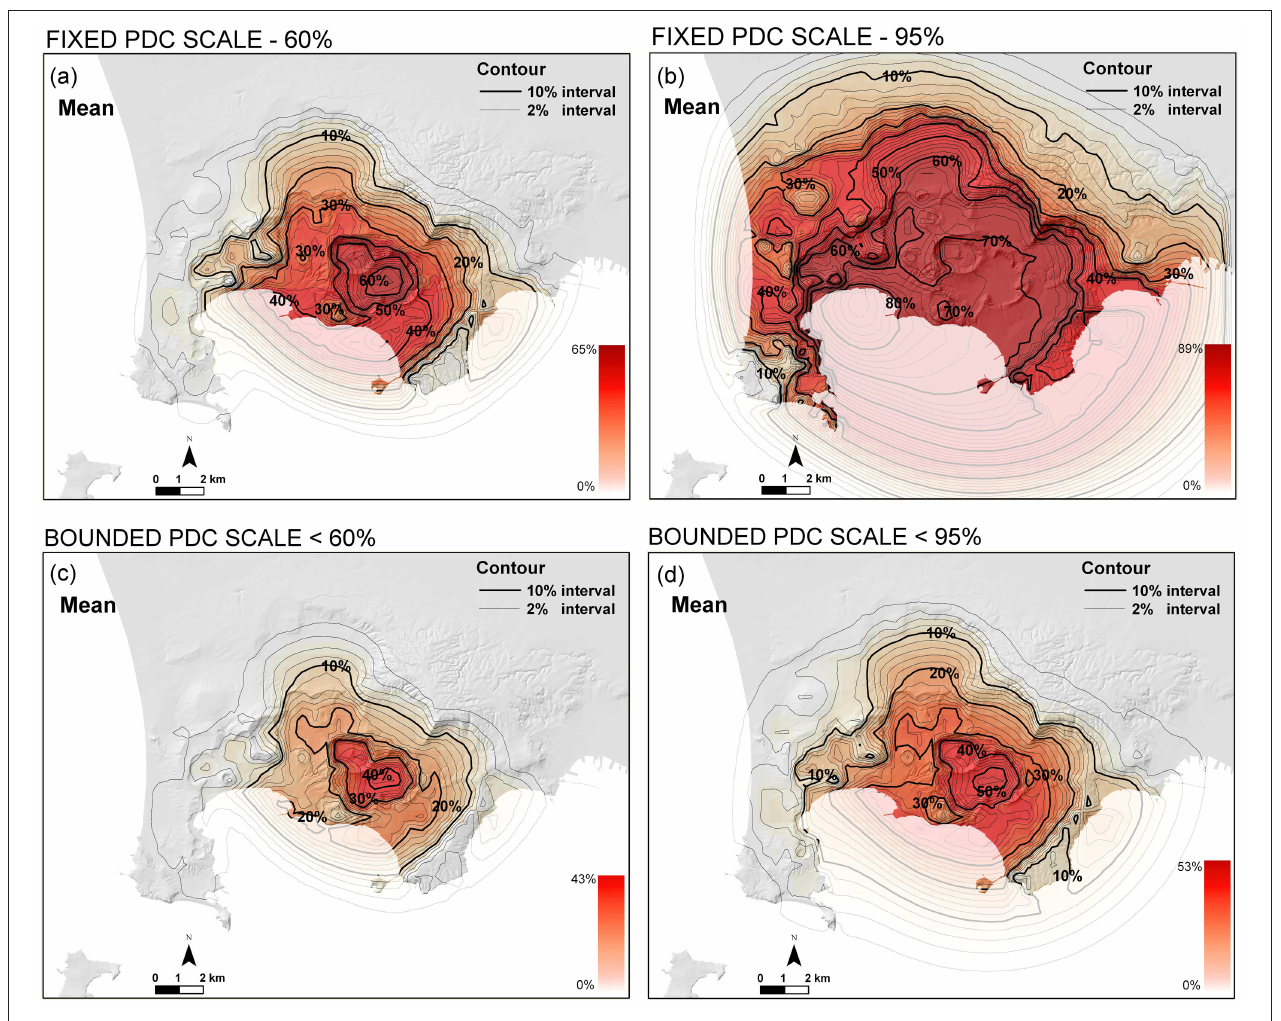
FIGURE 5 | (a,b) Mean PDC invasion hazard maps produced by assuming PDC invasion areas corresponding to the 60% (a) , and 95% (b) , respectively, of the distributions reported in Figure 3b . The two maps assume the vent opening probability displayed in Figures 3c,d for the two sectors of the caldera. Contours and colors indicate the mean percentage probability of PDC invasion conditional on the occurrence of an explosive event of that size, originating on-land. (c,d) PDC invasion hazard maps assuming PDC areal extent up to the assumed percentiles of the Figure 3b distributions, i.e., 60% in (a) , 95% in (b) , and the vent opening maps displayed in that figure. Contours and colors indicate the mean percentage probability of PDC invasion conditional on the occurrence of an explosive event of at most that size, originating